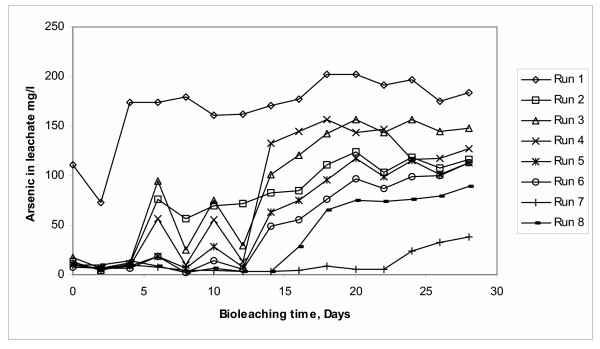
Arsenic Solubilized